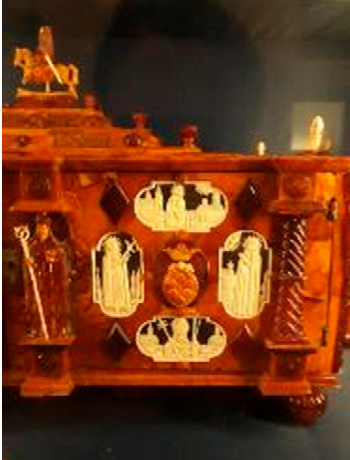
Figure 9. Danzig workshop, Reliquary of St. Kazimierz Jagiello ń czyk, c. 1677–1678 (right detail). Palazzo Pitti (Tesoro dei Granduchi), Florence. Photo by the author.